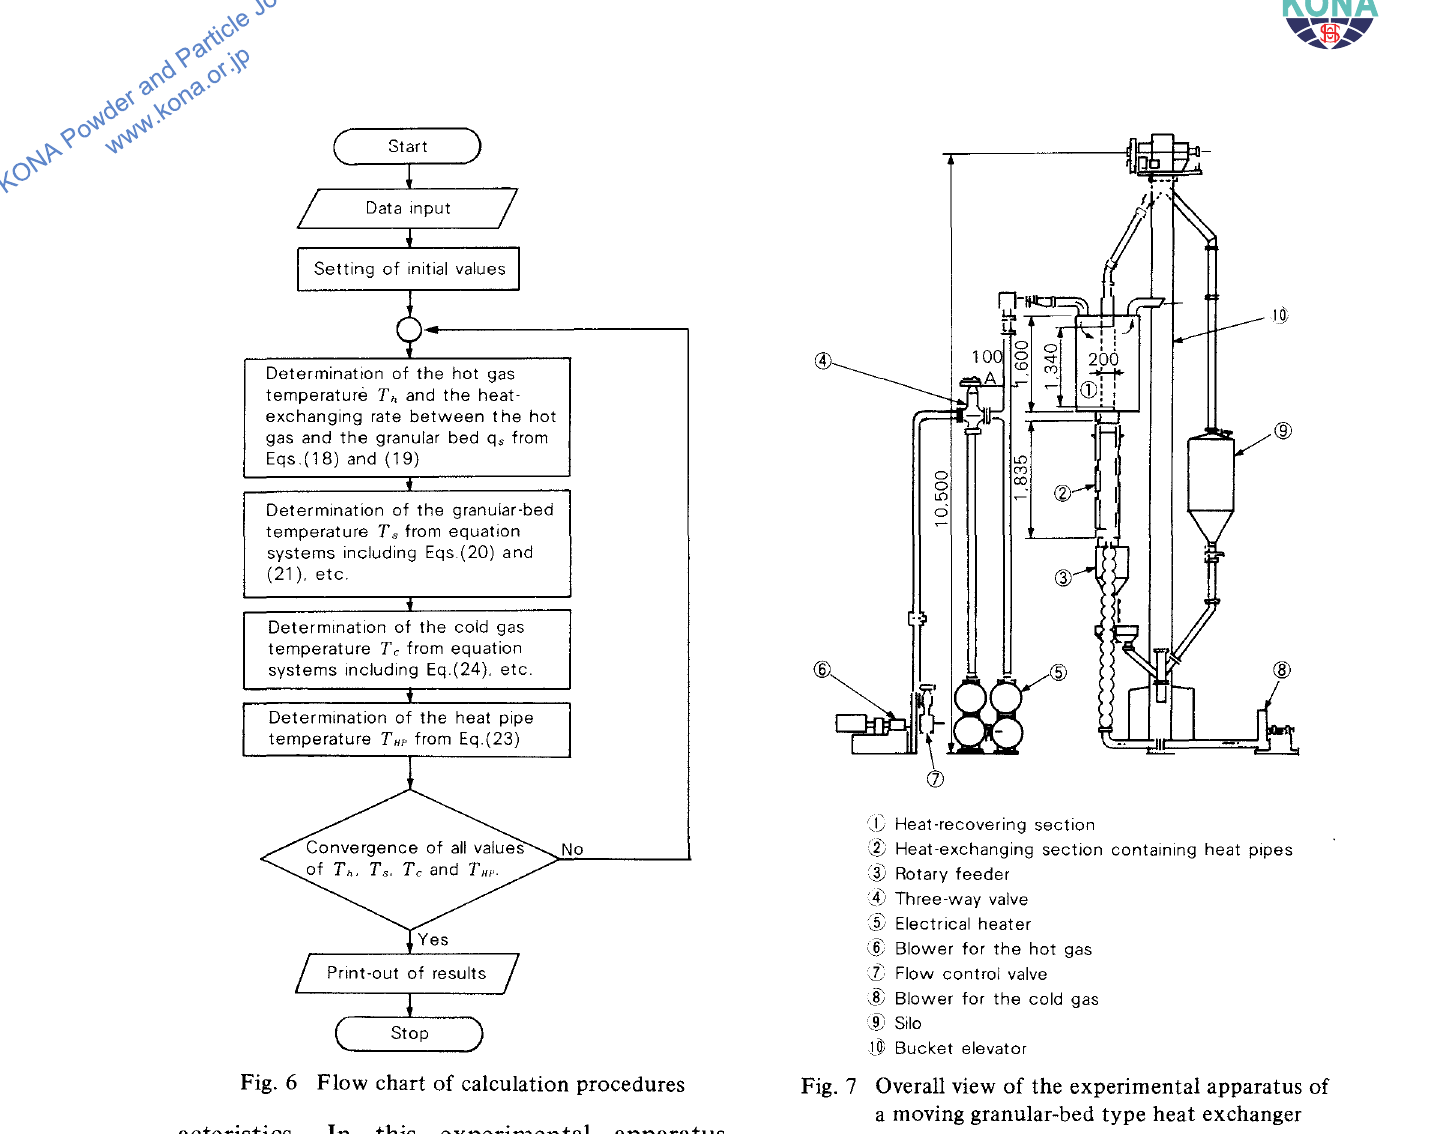
Fig. 6 Flow chart of calculation procedures Fig. 7 Overall view of the experimental apparatus